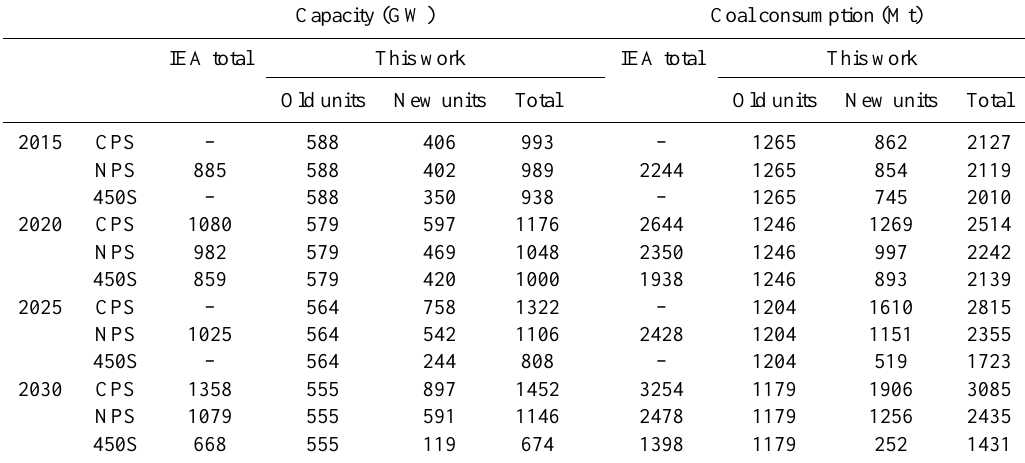
Table 2. Capacity and coal consumption of China’s coal-fired power plants predicted by the IEA and this